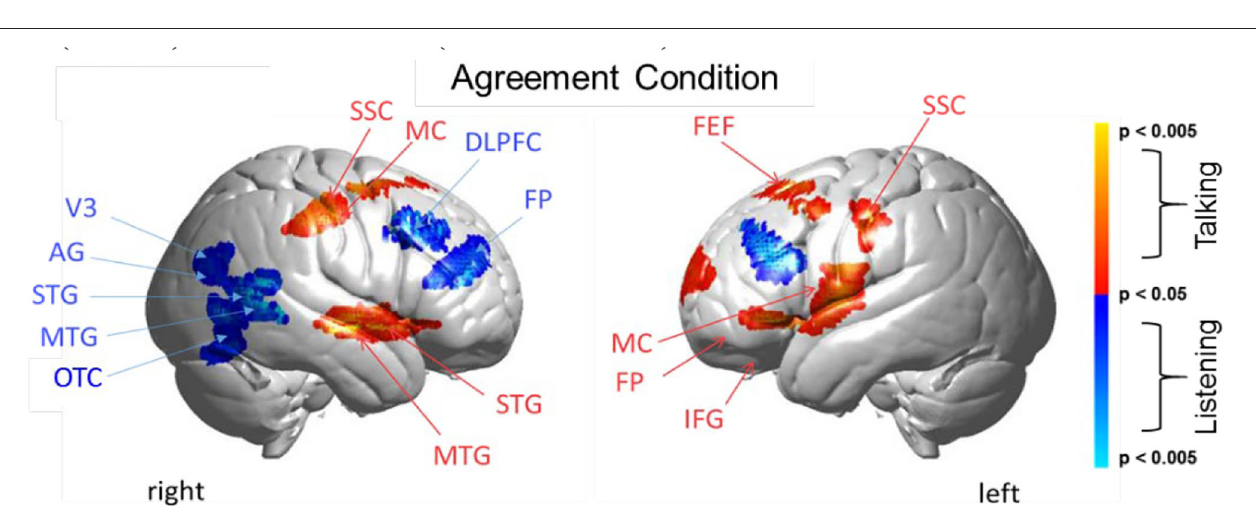
FIGURE 5 | Agreement condition. Brain activity clusters represent functions of talking [talking > listening] (red) and listening [listening > talking] (blue). Talking (relative to listening) during agreement with a partner engages the left frontal language system including components of Broca’s Area (anterior STG, superior temporal gyrus; IFG, inferior frontal gyrus; MC, motor cortex; FP, frontopolar cortex). Frontal systems engaged while talking are also observed bilaterally and include FEF, frontal eye fields; SSC, somatosensory cortex; MC, motor cortex. Listening during agreement (blue) engages regions in the right TPJ, temporoparietal junction; including AG, angular gyrus; STG, superior temporal gyrus; MTG, middle temporal gyrus; as well as visual cortex (V3) and face processing regions in the OTC, occipitotemporal cortex. Bilateral DLPFC, dorsolateral prefrontal cortex; FP, frontopolar cortex are also observed during listening when the partners are in agreement. See Table 4